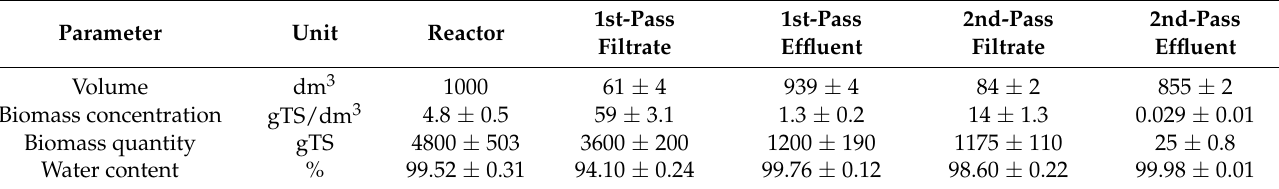
Table 4. Products of algal biomass